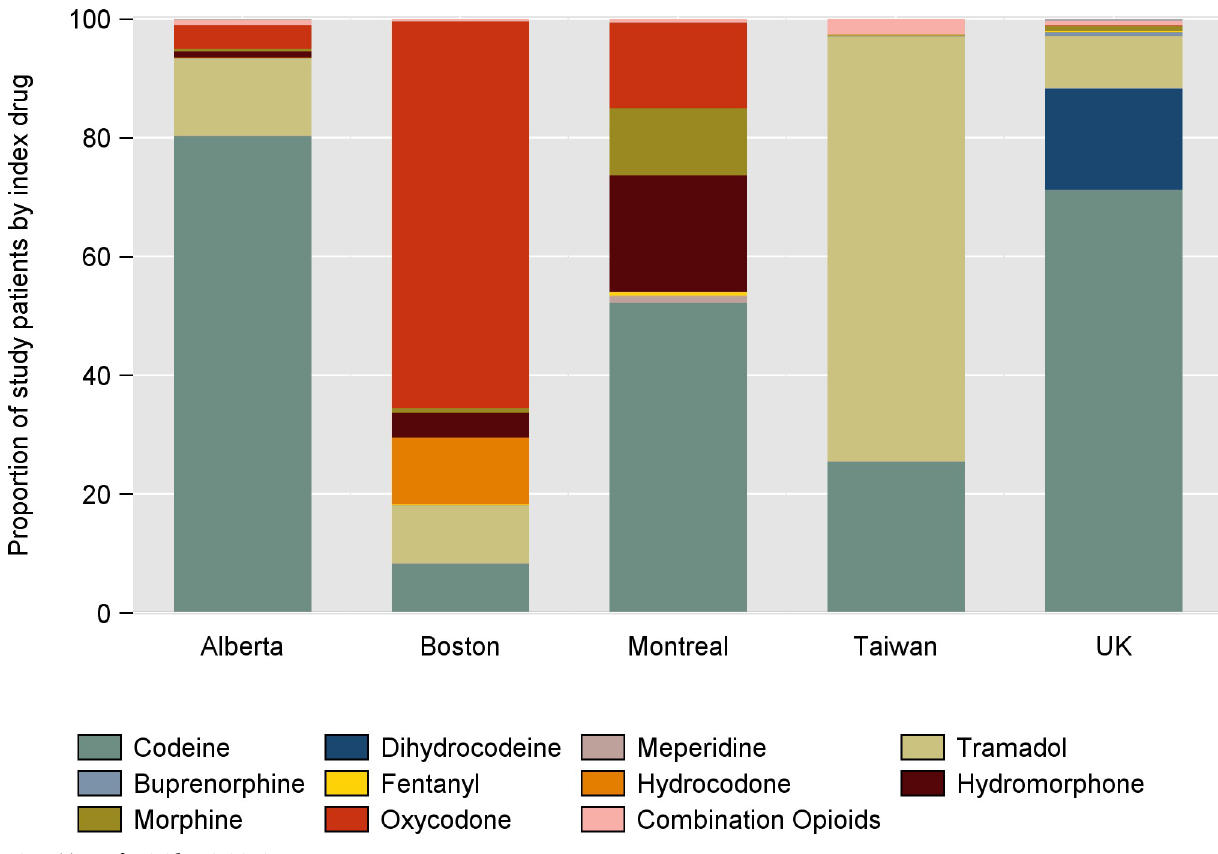
Fig 3. Type of opioid on